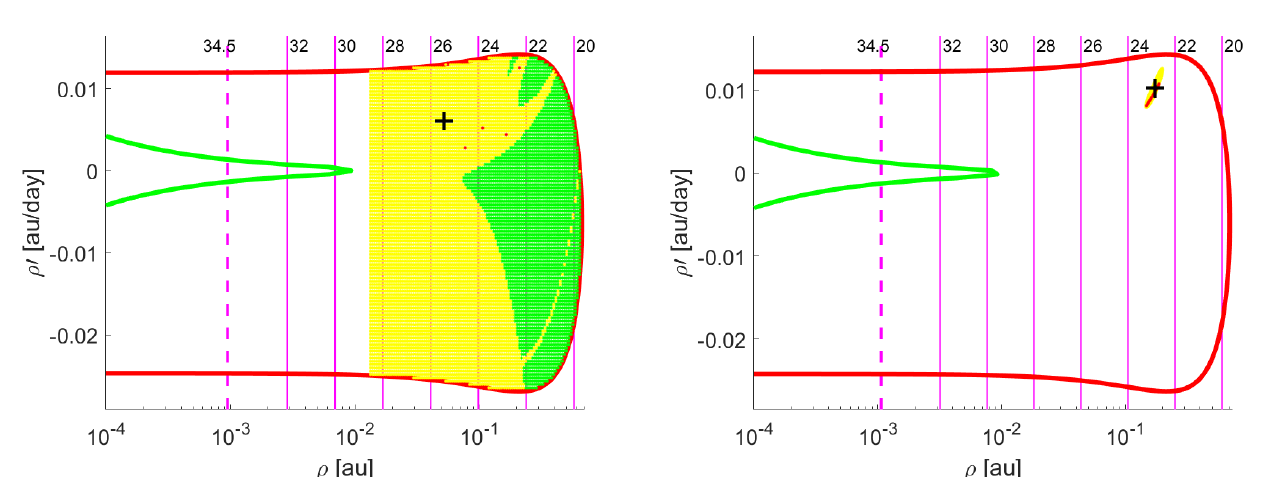
Figure 9. Results of the test of Tool 1 for asteroid C33TRV2 after the first night of observation (left) and after the second night (right).